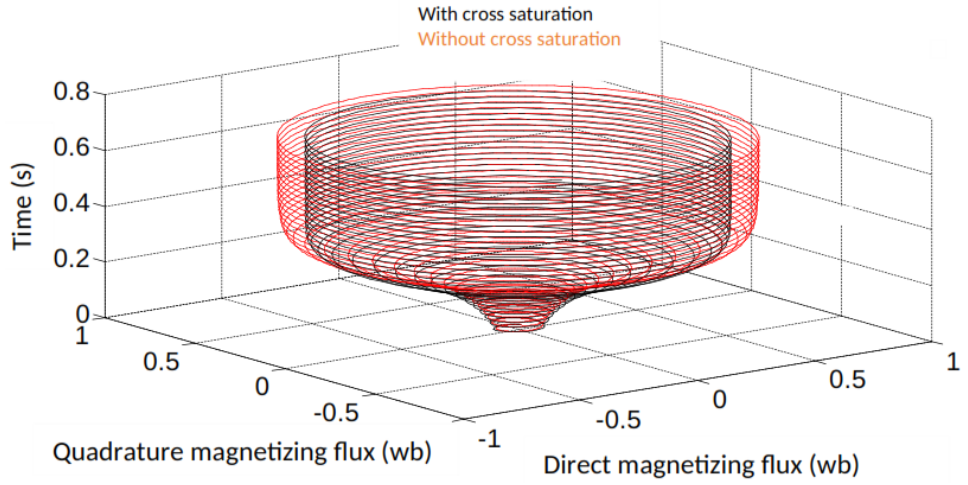
Figure 9. Simulation of the magnetizing flux with and without cross-saturation.